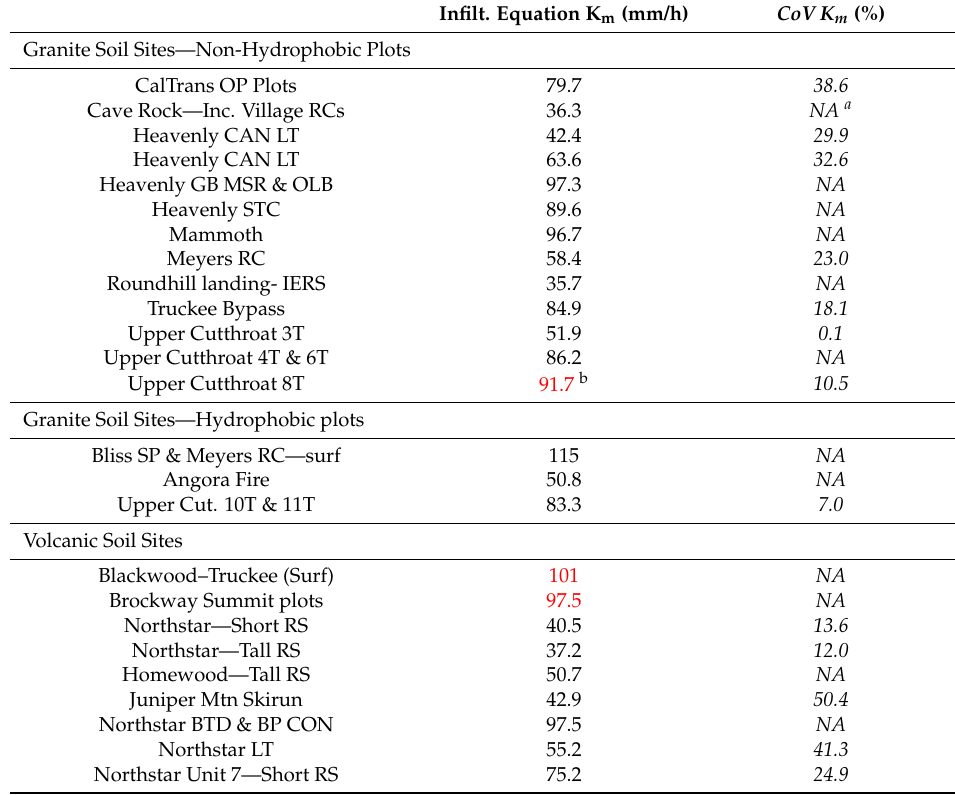
a : NA = Not Applicable usually because n < 3; b : Mean values highlighted in RED between sister runoff plots do not differ significantly ( p <